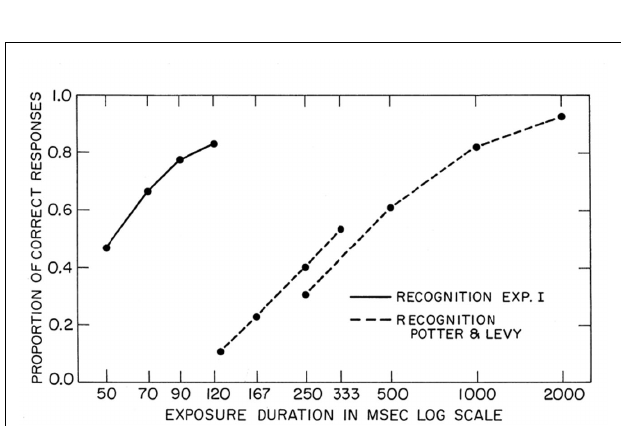
FIGURE 3 | Proportion of pictures recognized following single masked presentations (solid curve, Potter, 1976, Exp. 3) and proportion recognized after RSVP (dashed curves, two groups with different ranges of presentation durations; Potter and Levy, 1969). Data are corrected for guessing (see text footnote 1). Figure from Potter,